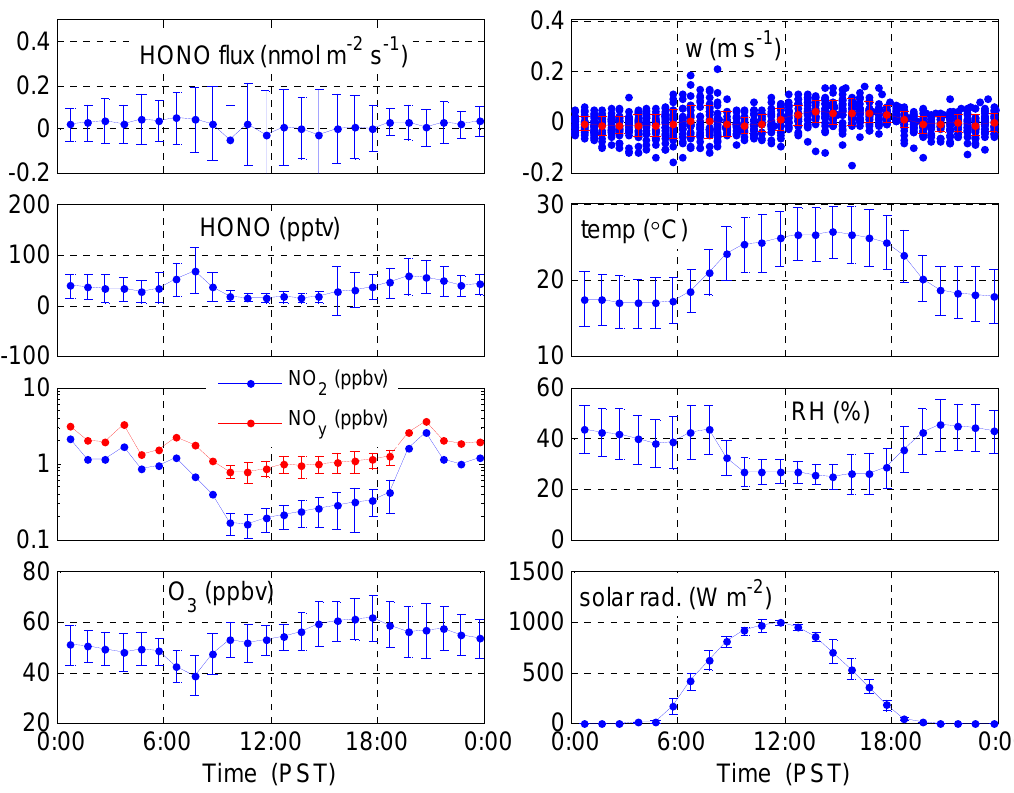
Fig. 6. Diurnal variations of HONO flux, HONO, NO 2 /NO y , O 3 , vertical wind velocity ( w ), temperature, relative humidity (RH) and solar radiation measured during the BEARPEX 2009 field study. Hourly diurnal mean values are shown and error bars represent 1 σ deviations of the measurements in the hourly bins. For vertical wind velocity ( w ), individual 30-min averages are also plotted as blue dots to show the variations in the data.